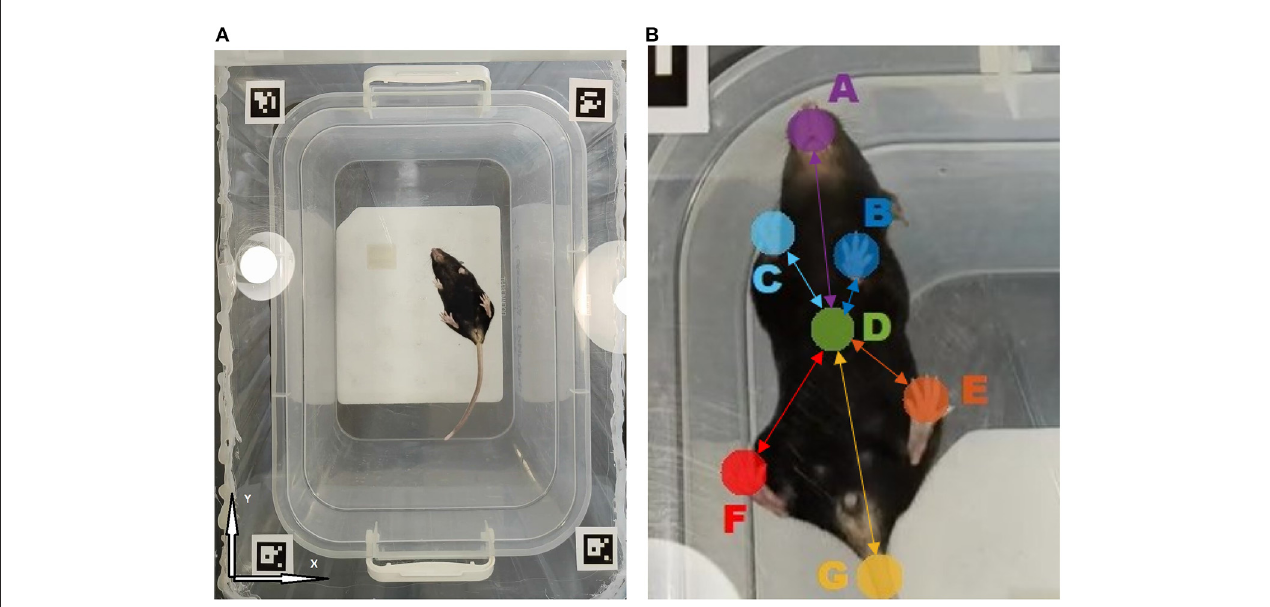
FIGURE1 (A) The overall view of the open field arena with transparent floor as observed by the camera located underneath. (B) Tracked animal body parts: A- Snout, B- Left front paw, C- Right front paw, D- Body midpoint, E- Left hind paw, F- Right hind paw, G- Tail. Connections represent the animal movement network model, where nodes are associated with animal body parts and edges characterize their mutual dynamics. Highlighted edges form the network backbone consisting of links between various body parts and animal body midpoint, while secondary links denote all pairwise connections (not shown). Each link is characterized by some mutual movement metric, such as the detrended cross-correlation coefficient R ij or partial correlation P ij ,